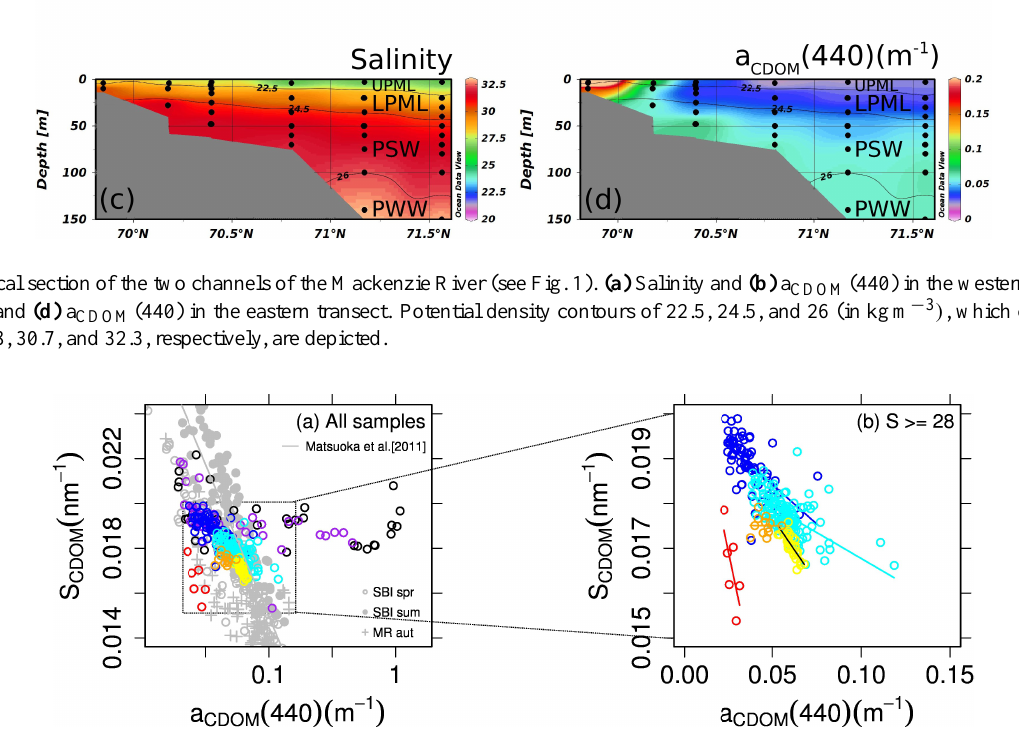
Fig. 7. S CDOM as a function of a CDOM (440) for (a) the whole salinity range and (b) salinity ≥ 28 (below the UPML). See Fig. 5 for symbols. Data from previous campaigns in the Western Arctic Ocean are also shown: Western Shelf-Basins Interactions (SBI) cruises for spring (SBI spr: grey open circles) and summer (SBI sum: grey closed circles) and Japanese Arctic campaign for autumn (MR aut: grey crosses) (Matsuoka et al.,